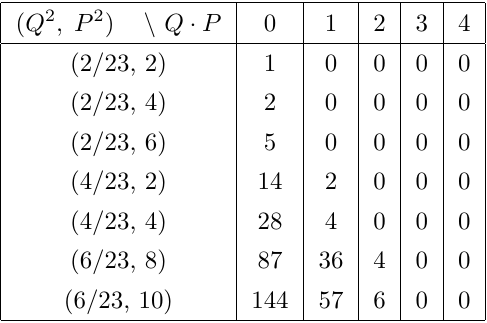
Table 14 . Index of horizon states for the 15 A orbifold of K 3 .